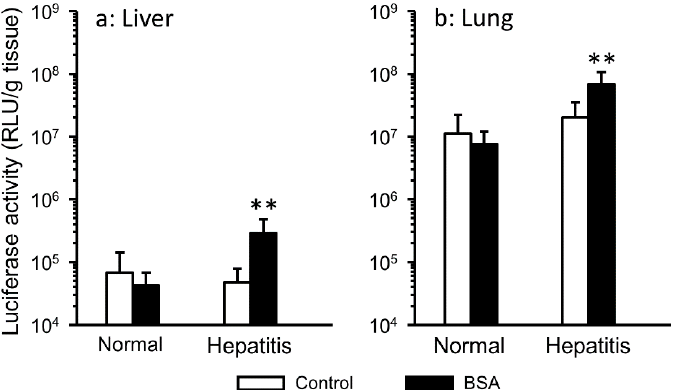
Figure 2. Effect of interaction of lipoplex with albumin on gene expression in the liver ( a ) and lung ( b ) after i.v. injection of lipoplex in normal or hepatitis mice. Lipoplex was incubated with 5% glucose (control) or BSA. Each bar represents the mean + SD of at least 6 experiments. Statistical method, Student’s t -test. ** p < 0.01 vs. control.